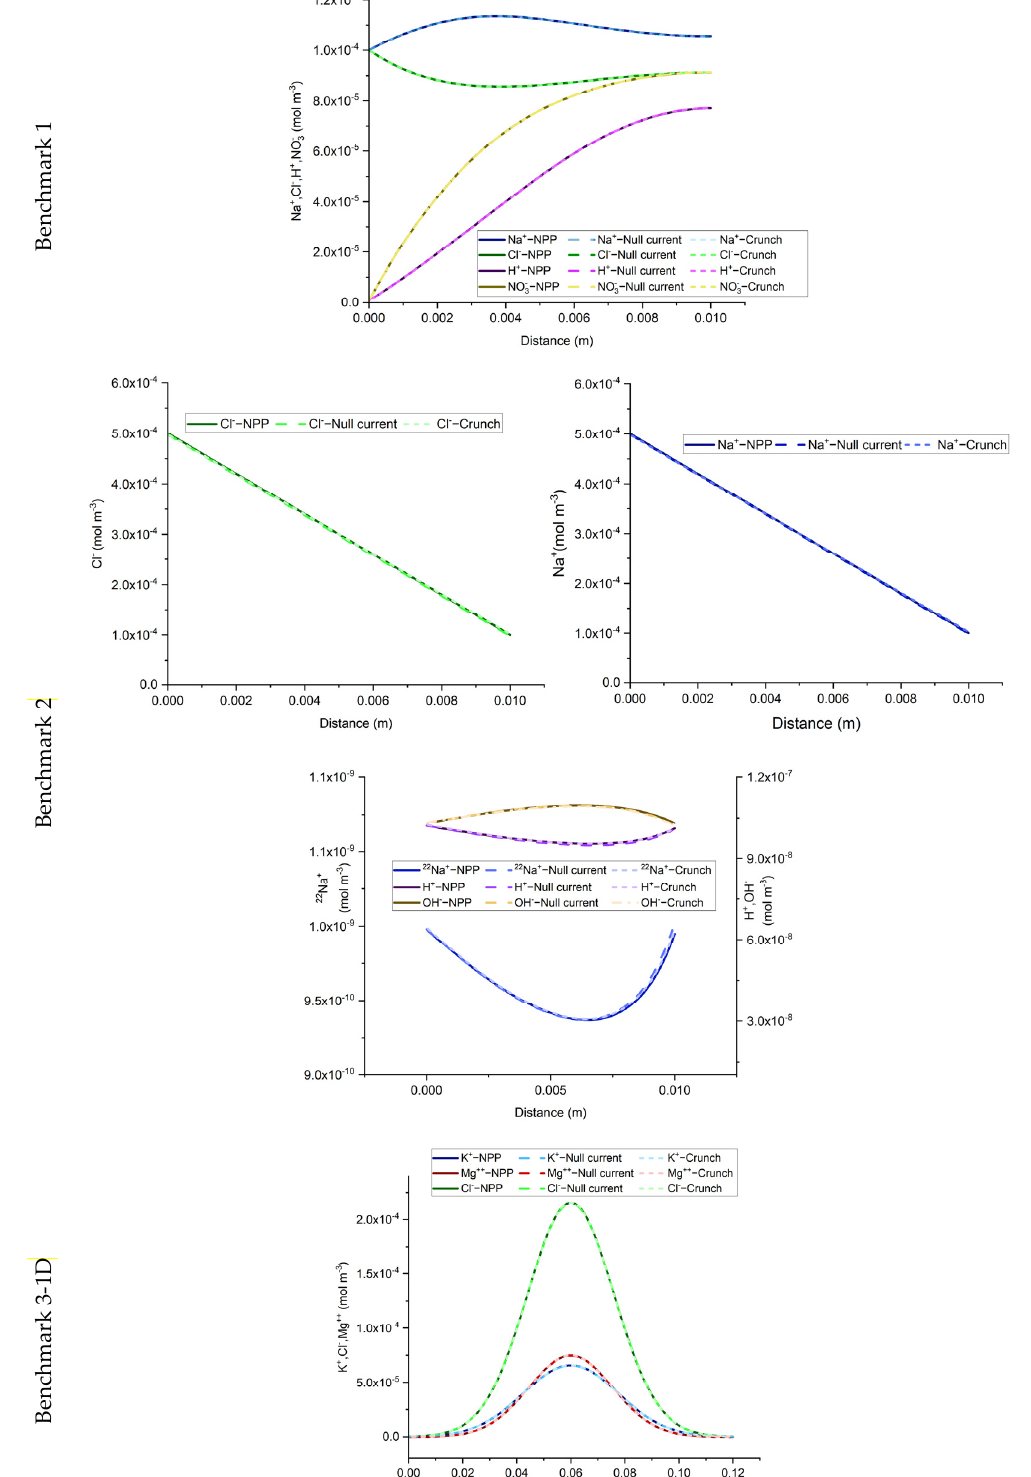
Figure 1. Comparison of the concentration results of the NPP, NC, and ‘Crunch’ models for the three 1D benchmarks. Dashed and continuous lines are indistinguishable showing perfect agreement between models.